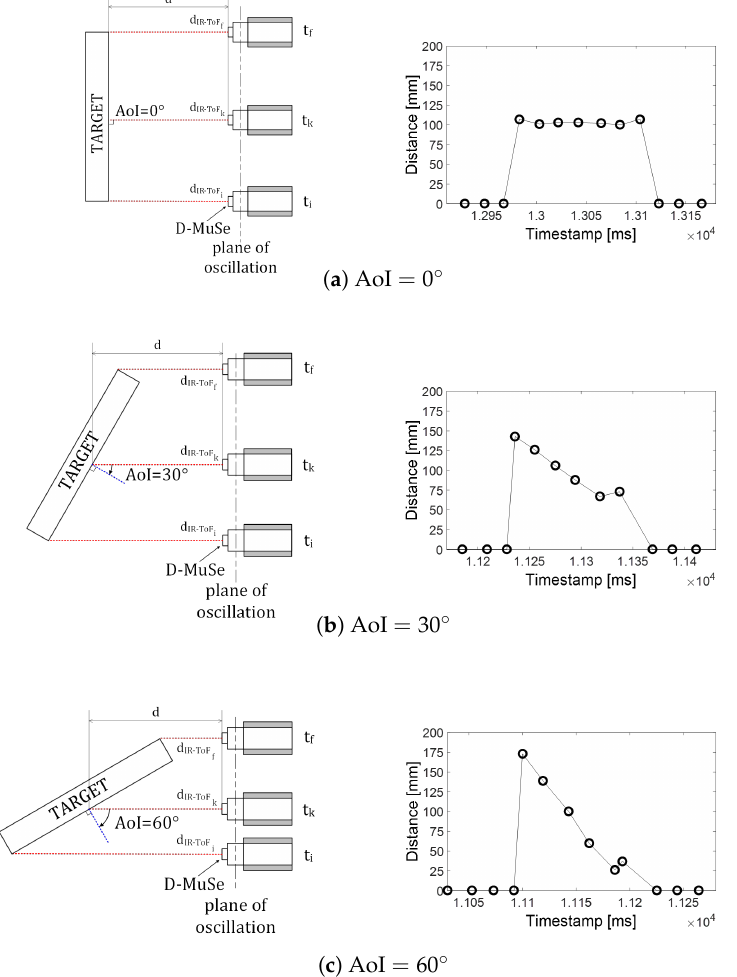
Figure 7. On the left, the top view of the experimental setup for AoI = 0 ◦ ( a ), 30 ◦ ( b ) and 60 ◦ ( c ). The red dotted line represents the infrared ray emitted by the IR-ToF proximity sensor. d is the imposed distance using a ruler, while d IR − ToF is the distance estimated by the Infrared Time-of-Flight proximity k sensor (IR-ToF) when the gyroscope measured a positive/negative peak according to the direction of the pendulum oscillation, while d IR − ToF and d IR − ToF are the initial and final estimated distances, i f respectively. On the right, for each AoI value, an example of the distance values measured by the IR-ToF proximity sensor at d = 100 mm is reported. It should be noted that, in dynamic acquisitions, when the AoI differs from zero, the sensor-target distance d IR − ToF varies with time between d IR − ToF i and d IR − ToF (Figure f